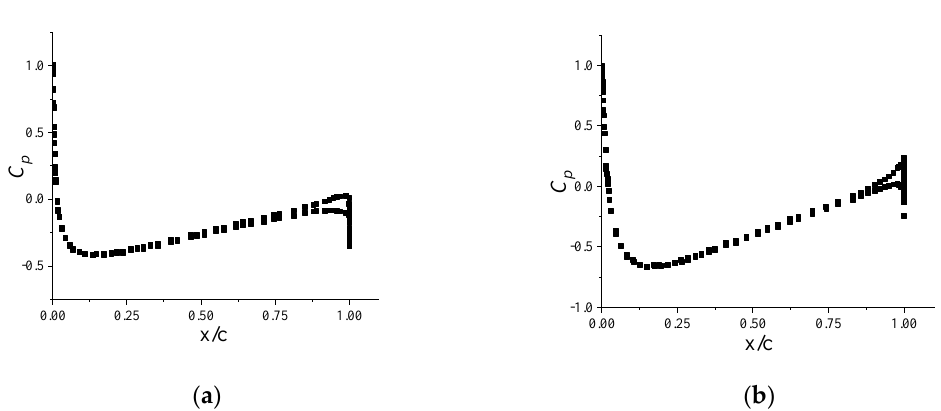
Figure 25. Vortex shedding of the 0018 model.